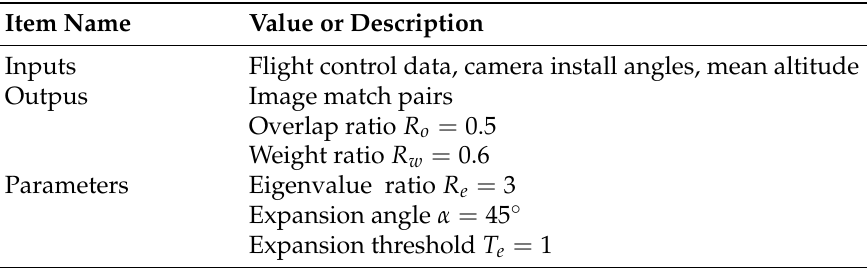
Table 1. The configuration of the MST-Expansion